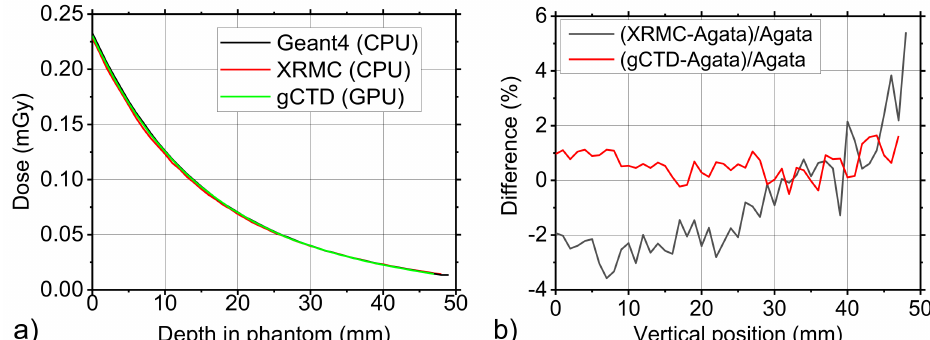
Figure 6. Line profiles of the simulated dose from the entrance surface to the rear of the breast phantom that was measured at the centre of phantom along the beam direction ( a ) and the percentage difference between the values that were provided by the different simulation code ( b ).